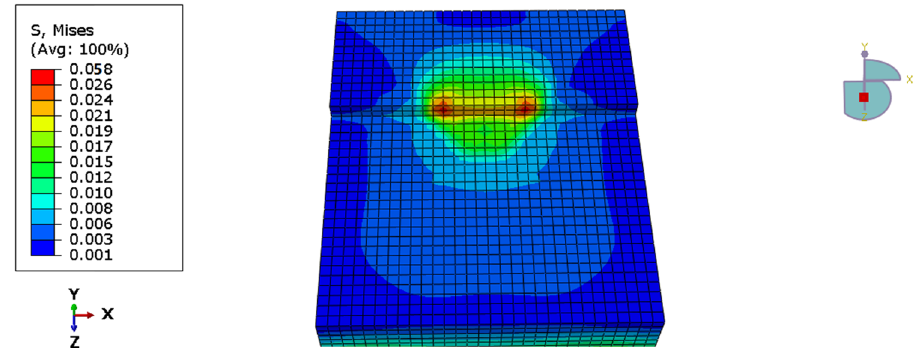
Figure 11: Stress distribution on soil behind thrust block ( MPa ) .